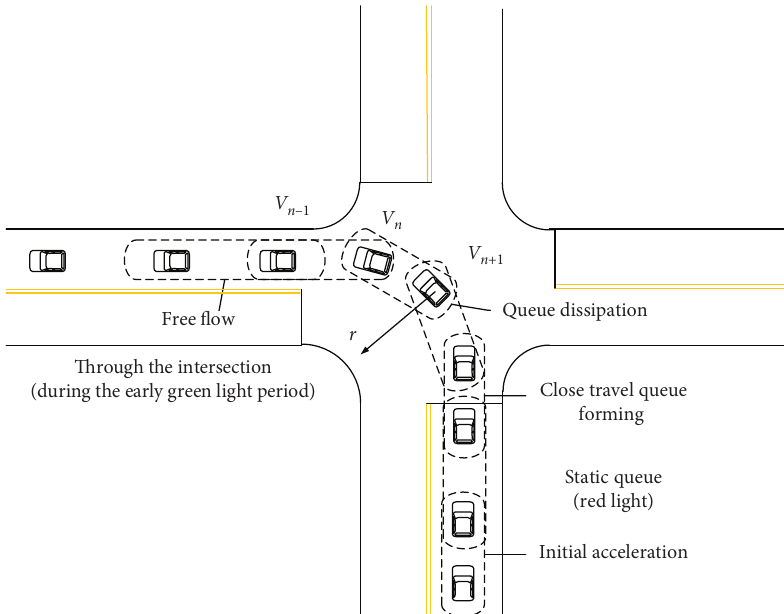
Figure 1: The basic mode of turning car-following behaviour at an